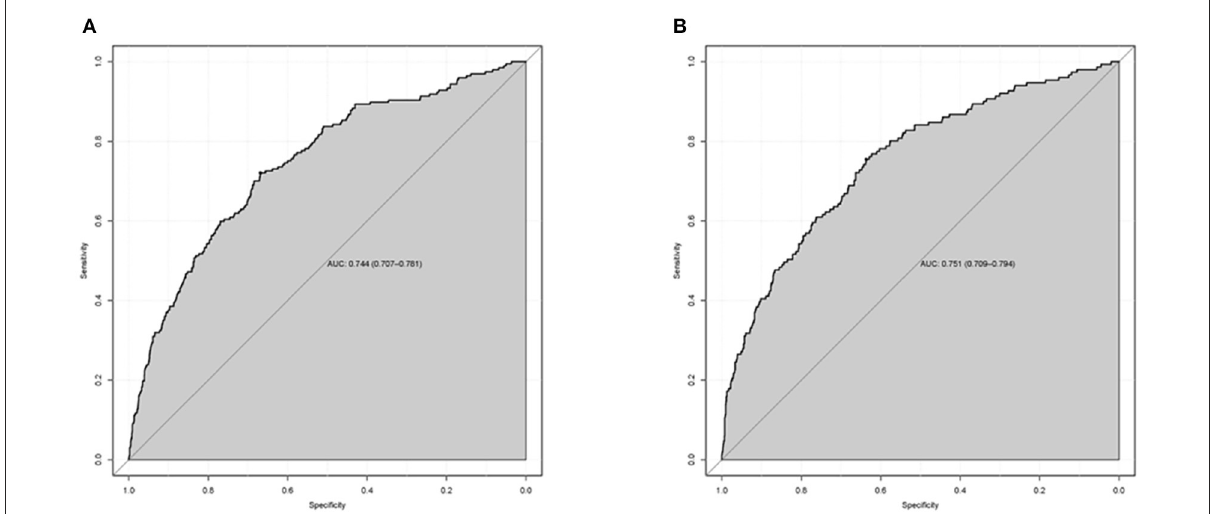
FIGURE4 The area under the receiver operating characteristic (ROC) curves (AUCs) of the nomogram for predicting 1-year all-cause mortality in training set (A) and validation set (B) . The ROC curve was drawn according to the predictive value of the nomogram and the 1-year all-cause mortality in elderly patients after cardiac surgery.